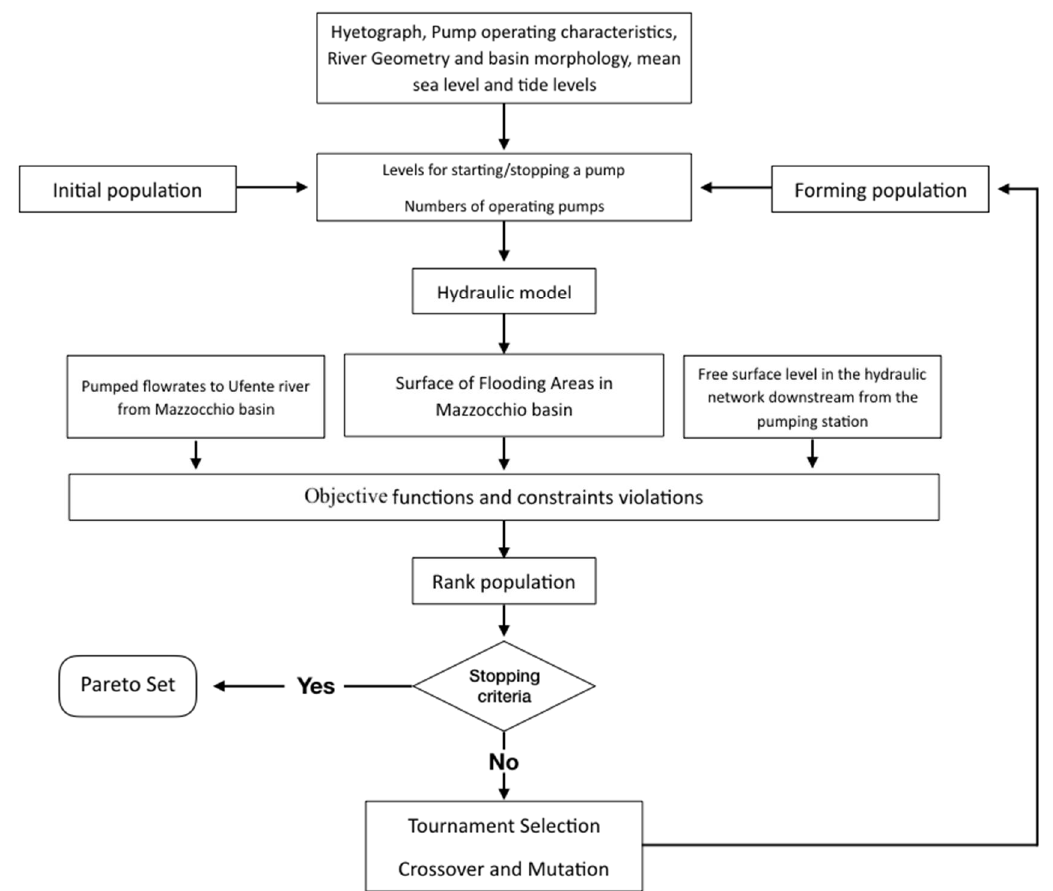
Figure 4. Optimization model’s flowchart.